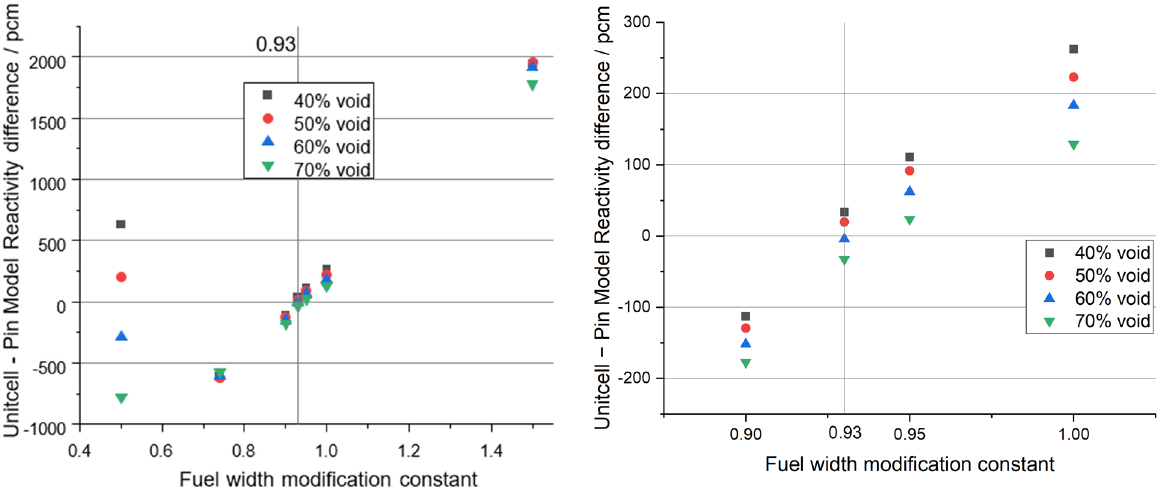
Figure 6. Reactivity difference between the axial and radial models of the pin in pcm units. When α is significantly below 1, with highly dense fuel represented in the model, the behavior of the pin model is inconsistent across different void fractions. The best agreement is found at a width reduction of 0.93, where the difference between the transformed pin model and the unit cell radial model is below 30 pcm across all void fractions calculated. Figures ( left ) and ( right ) are the same set of data, with different axis